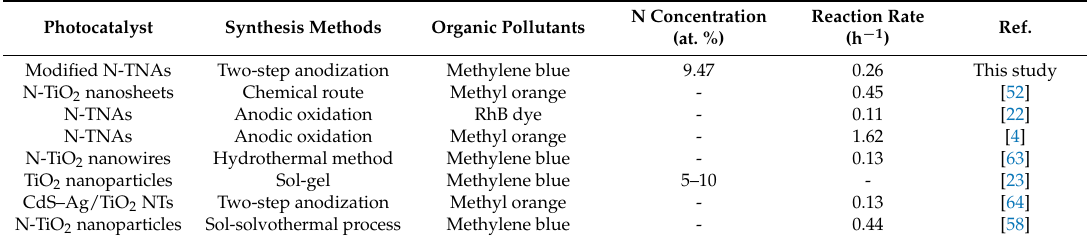
Table 2. N-doped TiO 2 -based nanomaterials, synthesis methods, organic pollutants, N-doping concentration, and reaction rates of the optimal N-TNAs in this study and in the relevant literature.